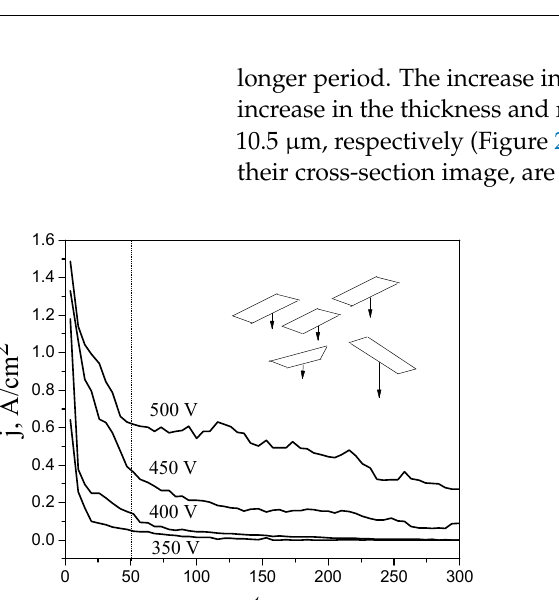
( c ) Figure 4. SEM image of the W-coating deposited at 450 V ( a ), element distribution maps ( b ), and the energy spectrum ( c ). The element distribution tracks along the cross-section of the coating are shown in Figure 5. Mg and O prevail in the boundary between the coating and the magnesium sub- strate, which is explained by the oxide layer MgO formation. Closer to the surface layer, the amount of Mg increases again, as well as the amounts of Si and O. The energy spectrum (Figure 5b) shows that Mg, Si, and O are the predominant ele- ments in the cross-section of the coating, while the amount of Ca is lower inside the coat- ing than on the coating’s surface. Fluorine is also present, mostly in the coating’s cross- section, because the MgF 2 was formed together with the oxide in the protective layer be- tween the substrate and the coating. The presence of sodium was revealed in the coatings. It is possible that it diffused from the electrolyte and embedded into the amorphous phase of the coatings.